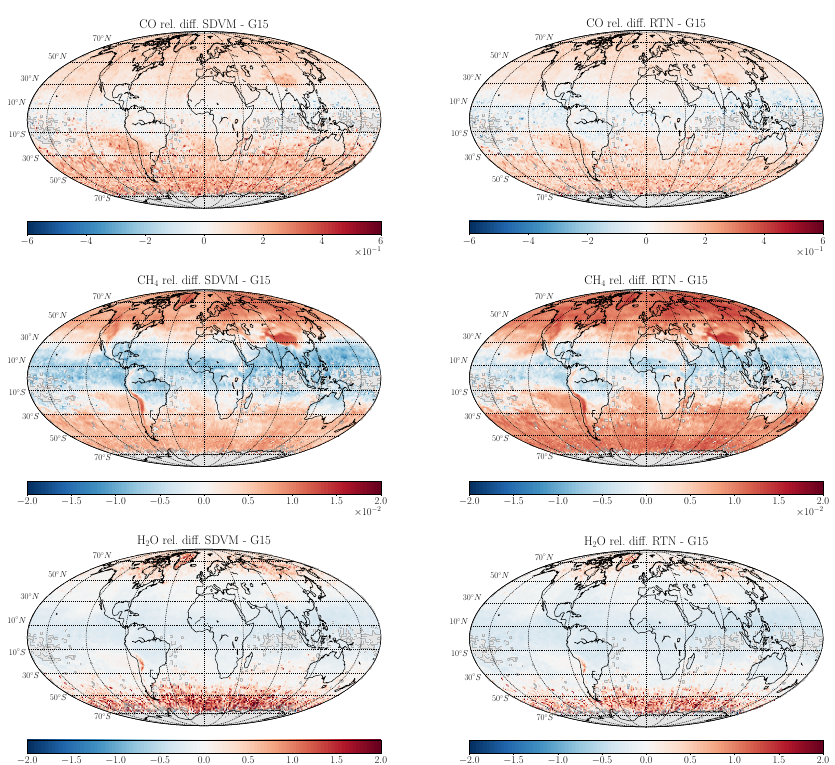
Figure A2. Left column: Relative difference of SDVM to G15. Right column: Rautian to G15 relative difference.